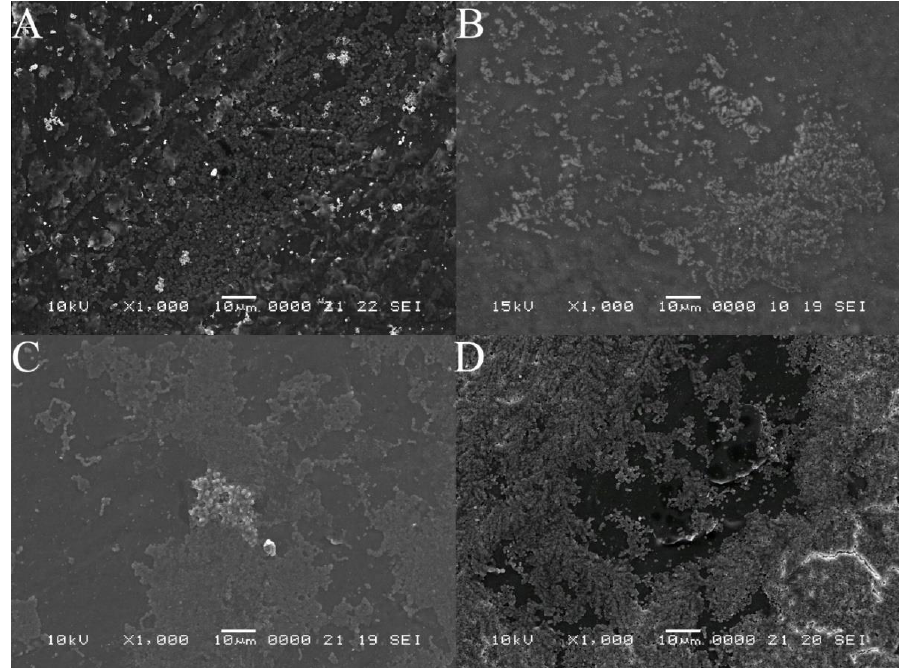
Figure 6. Scanning electron microscopy (SEM) images at X1000 magnification, showing bacterial growth on the 3D-printed PLA plate. ( A ) = Enterococcus faecalis , ( B ) = Staphylococcus aureus , ( C ) = Klebsiella pneumoniae and ( D ) = Pseudomonas aeruginosa . The strains used were Staphylococcus aureus ATCC 25923, Enterococcus faecalis ATCC 29212, Klebsiella pneumoniae ATCC 13883 and Pseudomonas aeruginosa ATCC 27853 .